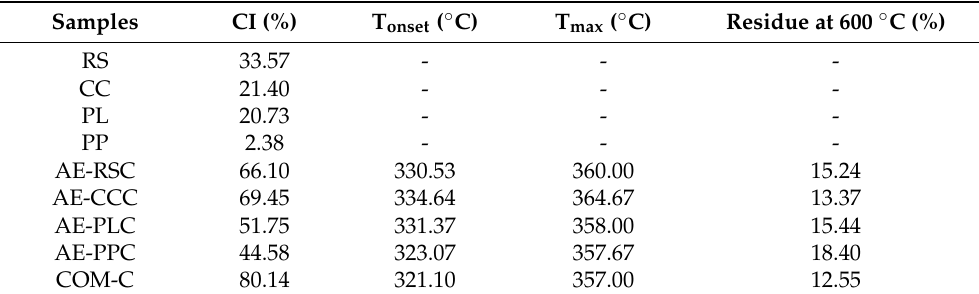
Table 2. Crystallinity index (CI) and thermal degradation temperature of cellulose samples extracted without and with the alkaline